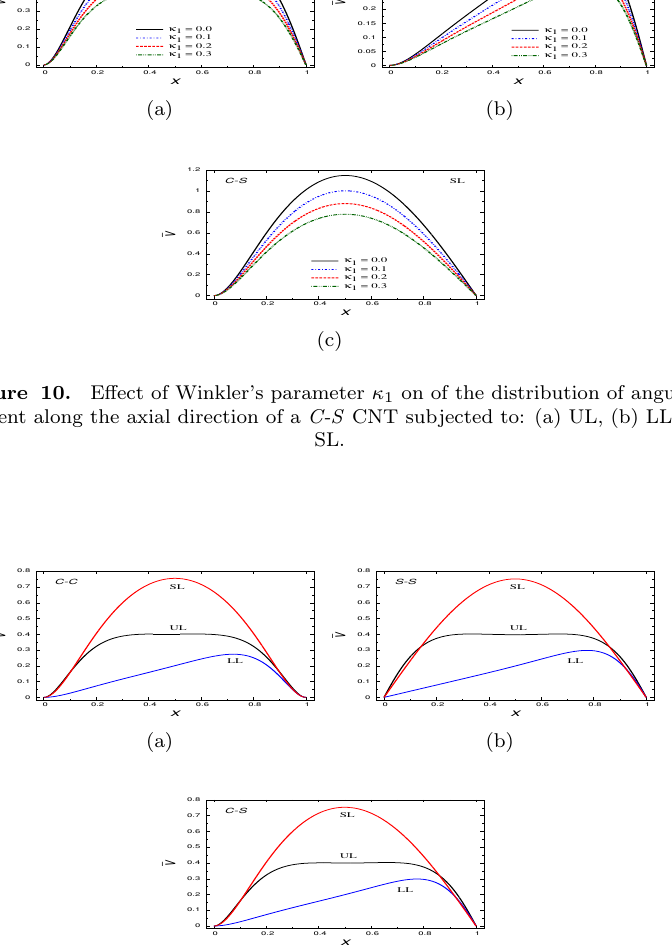
It is interesting to note that there are two absolute maximum points have the same value for CNTs under uniform load for small values of ξ , greater values of c t , and all values of κ 1 . Let us consider the S-S CNT under